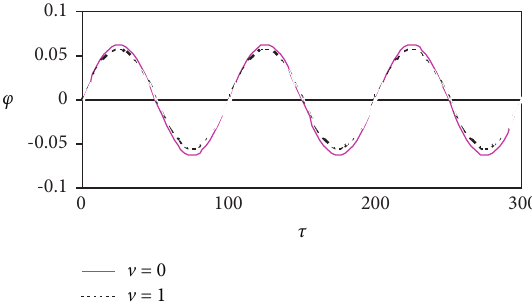
Figure 11: The numerical solutions for case (iv) in Section 4.1.